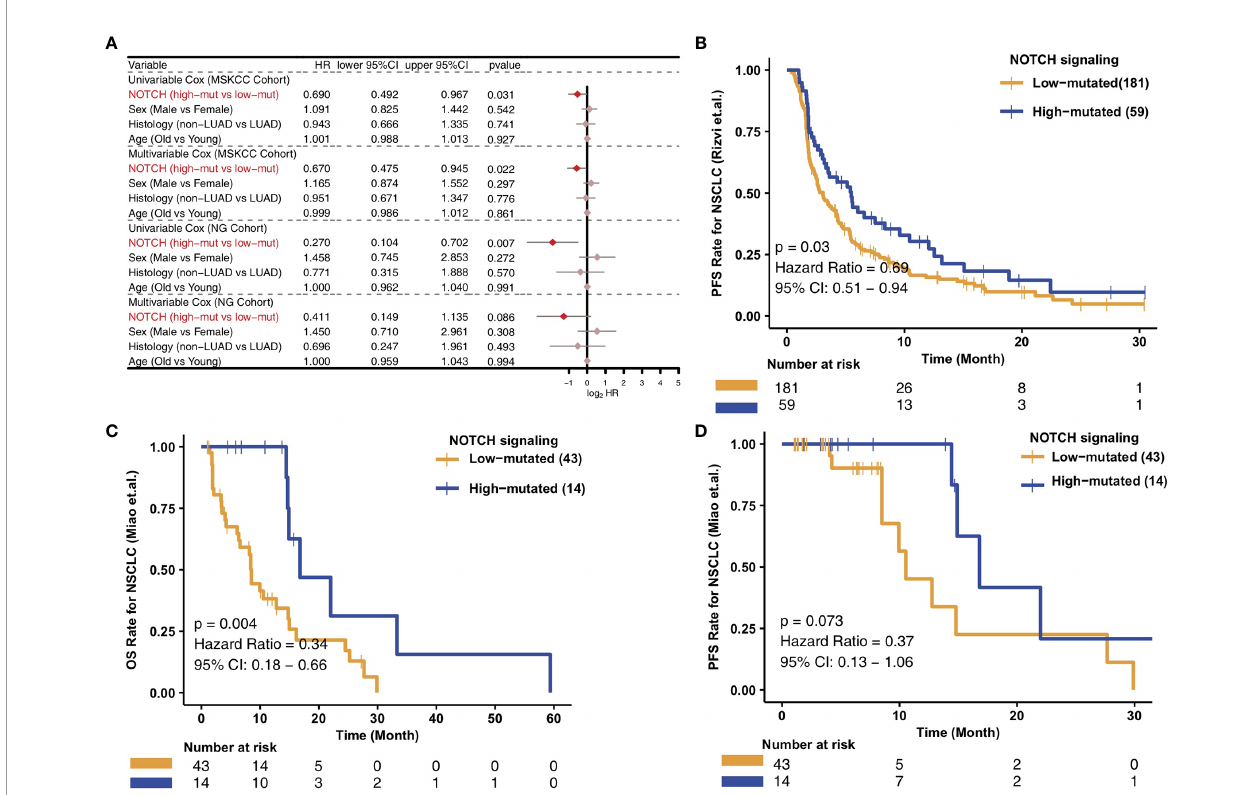
FIGURE 1 | Predictive value of clinical characteristics and the NOTCH signaling mutation status on ICI ef fi cacy. (A) Forest plot of the results of the univariate and multivariate Cox regression analyses of the MSKCC and NG cohorts. The main portion of the forest plot presents the hazard ratio (HR) and 95% con fi dence interval (95% CI), where the red dots indicate p < 0.05. The HR indicates the predictors of favorable (HR < 1) or poor (HR > 1) outcomes. (B) KM survival curves of PFS in 240 NSCLC patients from the MSKCC cohort. (C) KM survival curves of OS in 57 NSCLC patients from the NG cohort. (D) KM survival curves of PFS in 57 NSCLC patients from the NG